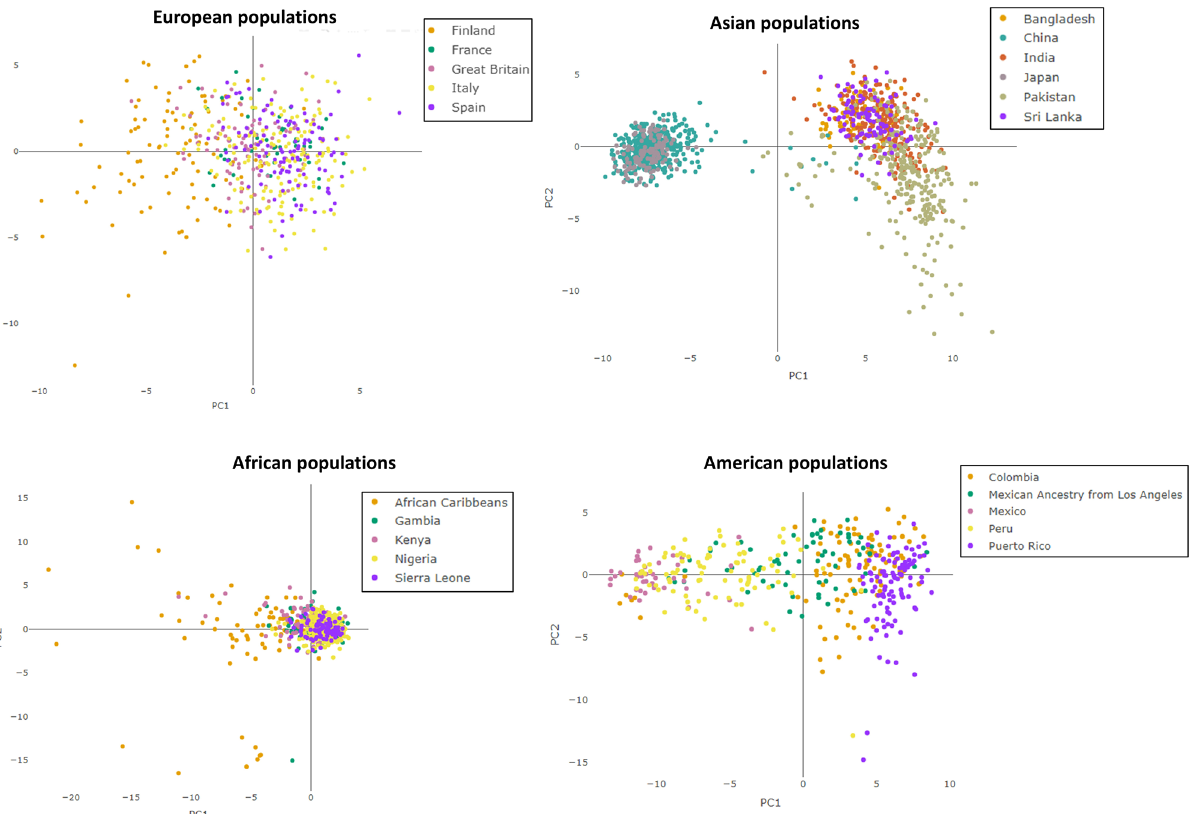
Figure 6. PCA Scores plots showing the PCA models obtained for the different countries and populations tested using the Maplex panel.